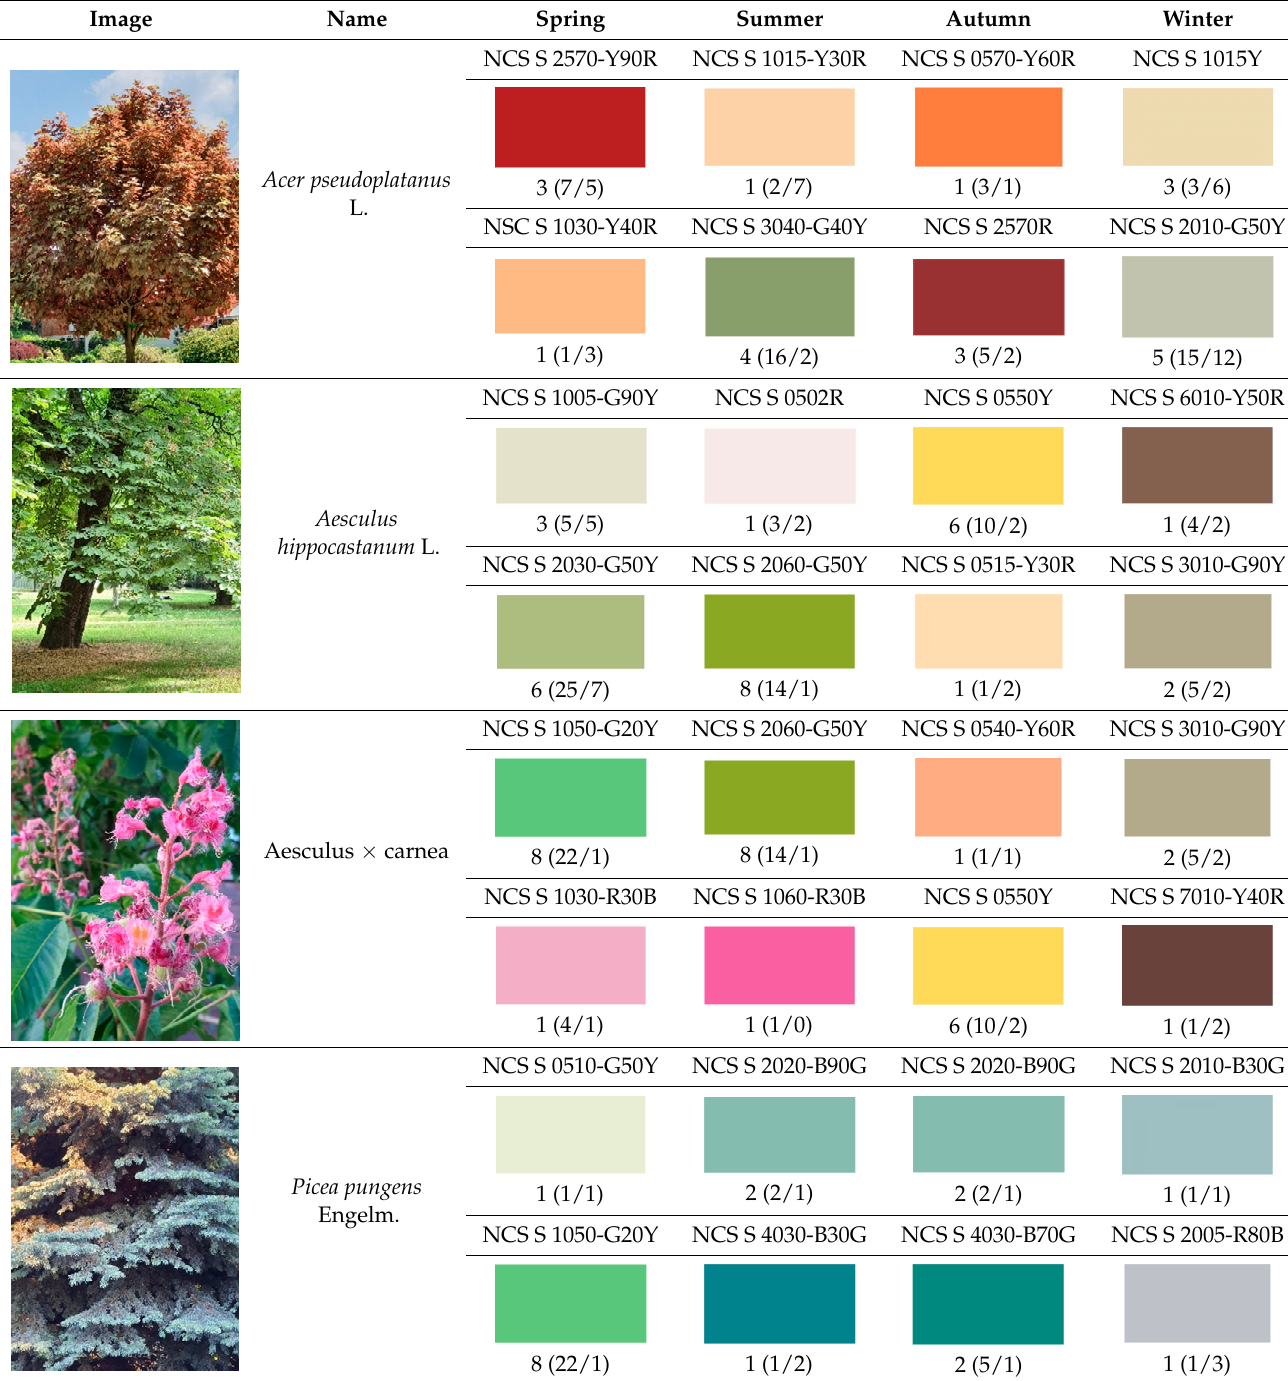
Table A1. Eighty-eight color samples taken from trees identified in the research area. The numbers below the color sample provide the information how many times a given color appears in the table (how many times it appears in all natural samples/how many times it appears in the analyzed architectural objects). Image. Table A1. Cont. Image.